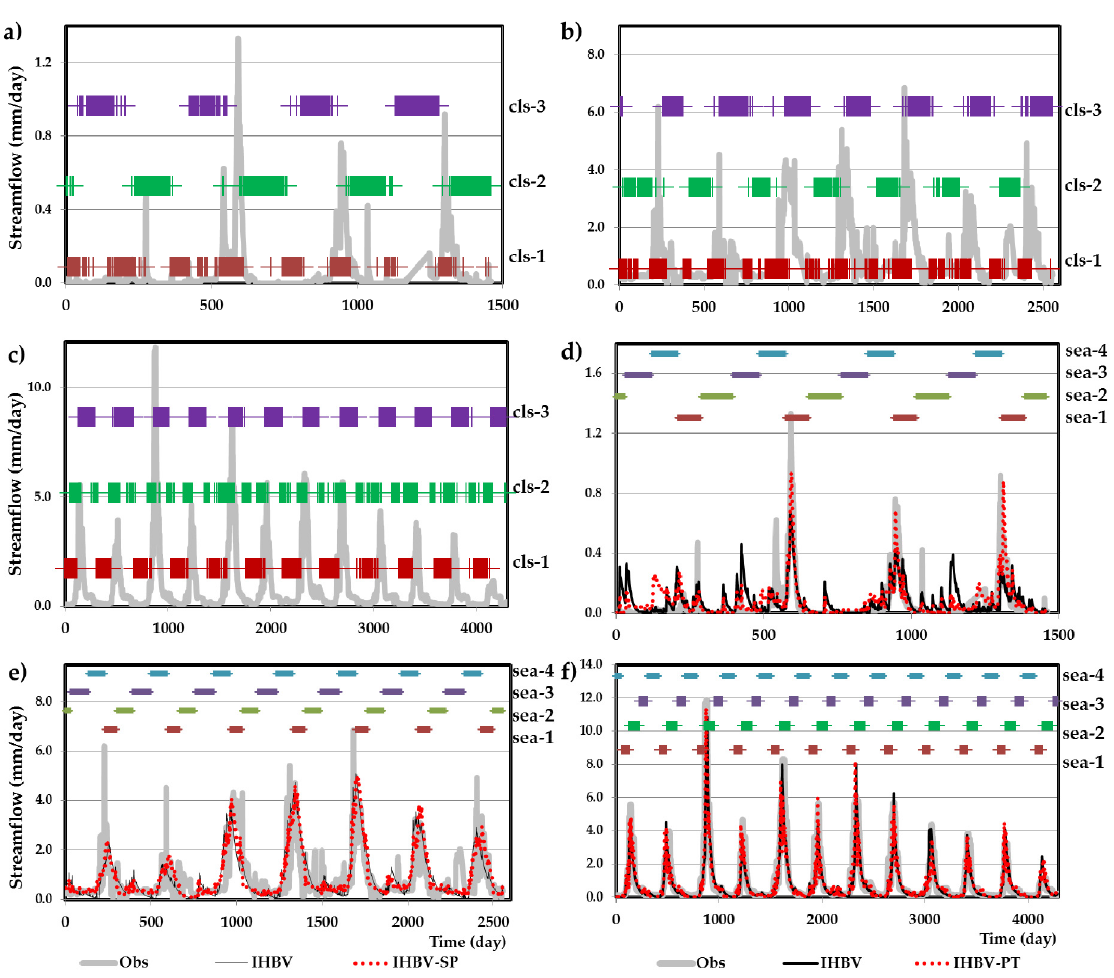
Figure 8. Comparison of different clustering levels in ( a ) Ajichai; ( b ) Lighvan; and ( c ) North Fork; and comparison of IHBV-SP results with the observed flow in ( d ) Ajichai; ( e ) Lighvan; and ( f ) North Fork in test period.